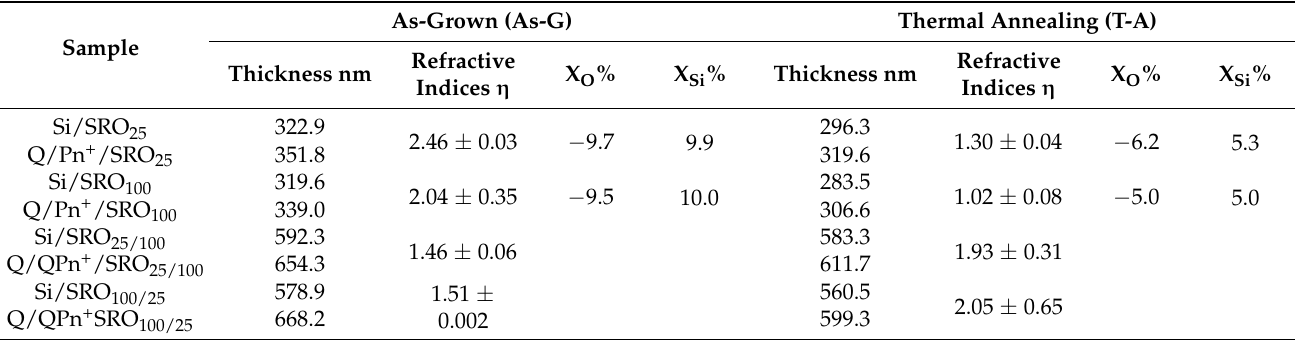
Table 1. Thickness, refractive indices, and excess silicon of the SRO 25 , SRO 100 , SRO 25/100, and SRO 100/25 .